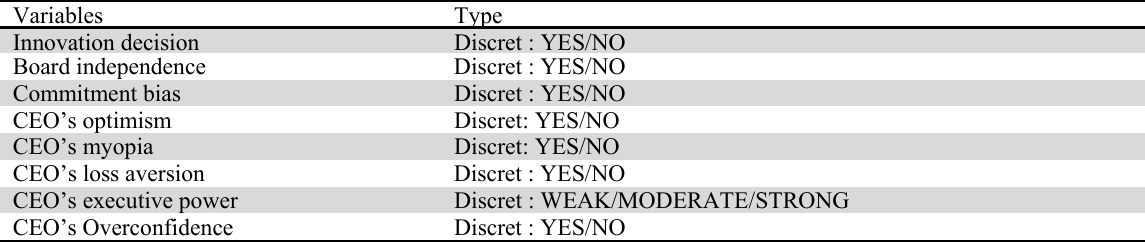
The network variables’ definition and